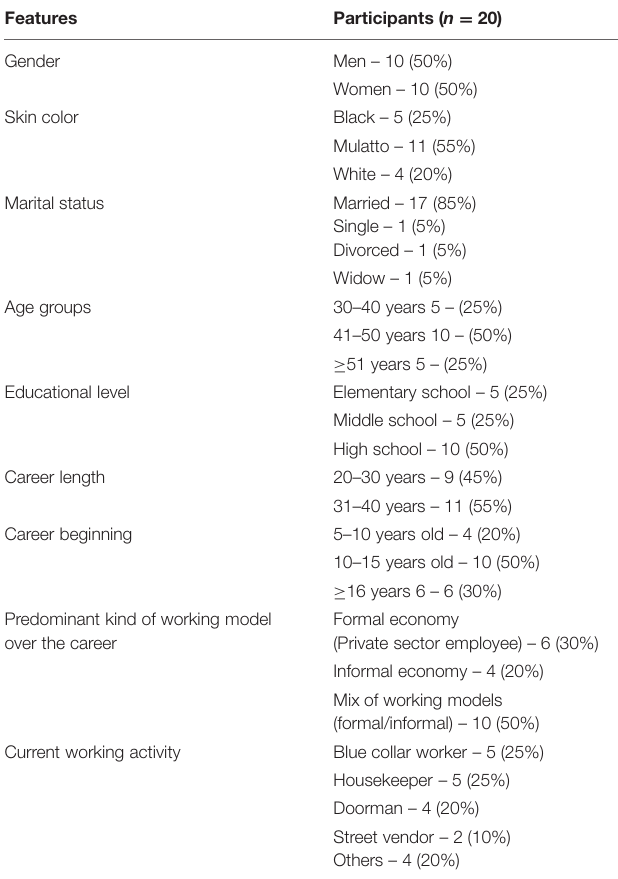
TABLE 1 | Characterization of the set of